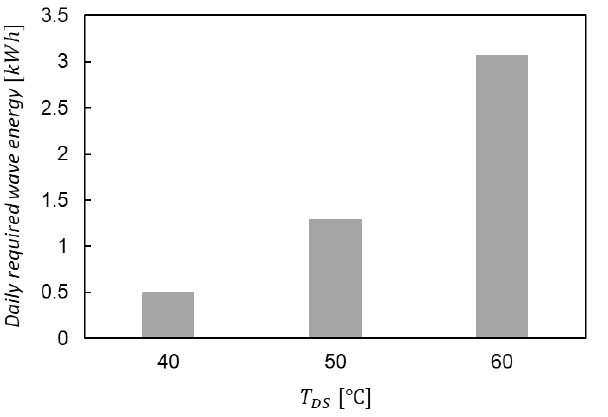
Figure 12. Daily required wave energy for the WavoWater operation according to the DS tempera- ture.